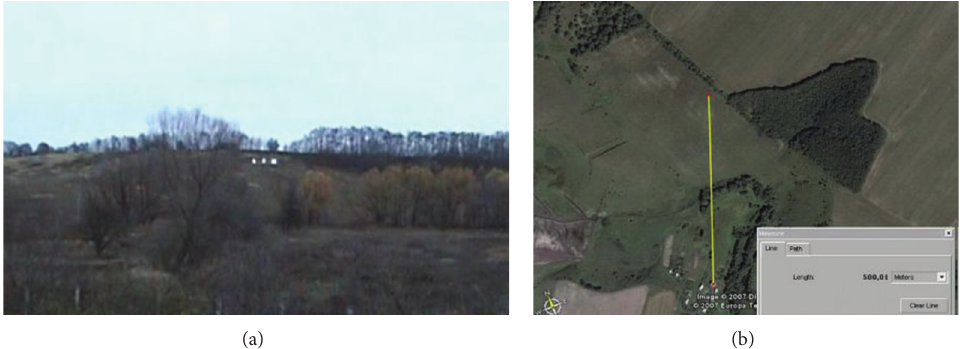
Figure 12: (a) Target scene; (b) Google image depicting the positions of the system and of the